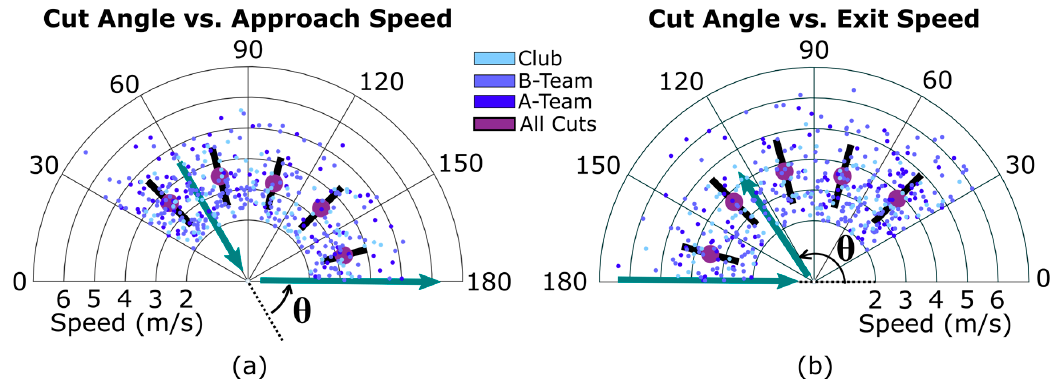
Figure 4. Distribution of approach ( a ) and exit ( b ) speeds for different cut angle ranges (in degrees). The large purple dot shows the average speed for each cut angle range, while the black line shows standard deviation. Speeds from the three teams are shown in different colors, and an example path of a player through a cut is shown in green arrows. The polar axes are restricted to better show trends; 4 outlier speeds are outside this view.